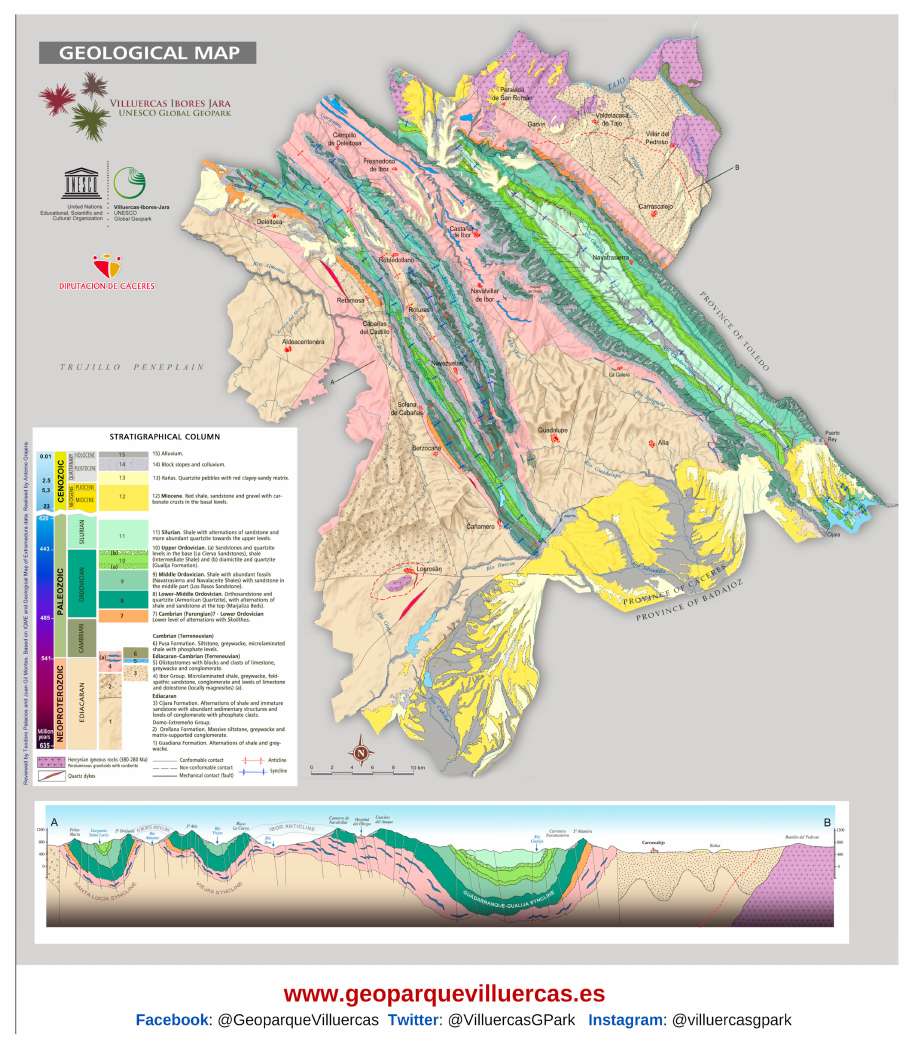
Figure 2. Geological map of the Villuercas. UNESCO Global Geopark Villuercas-Ibores-Jara [56].